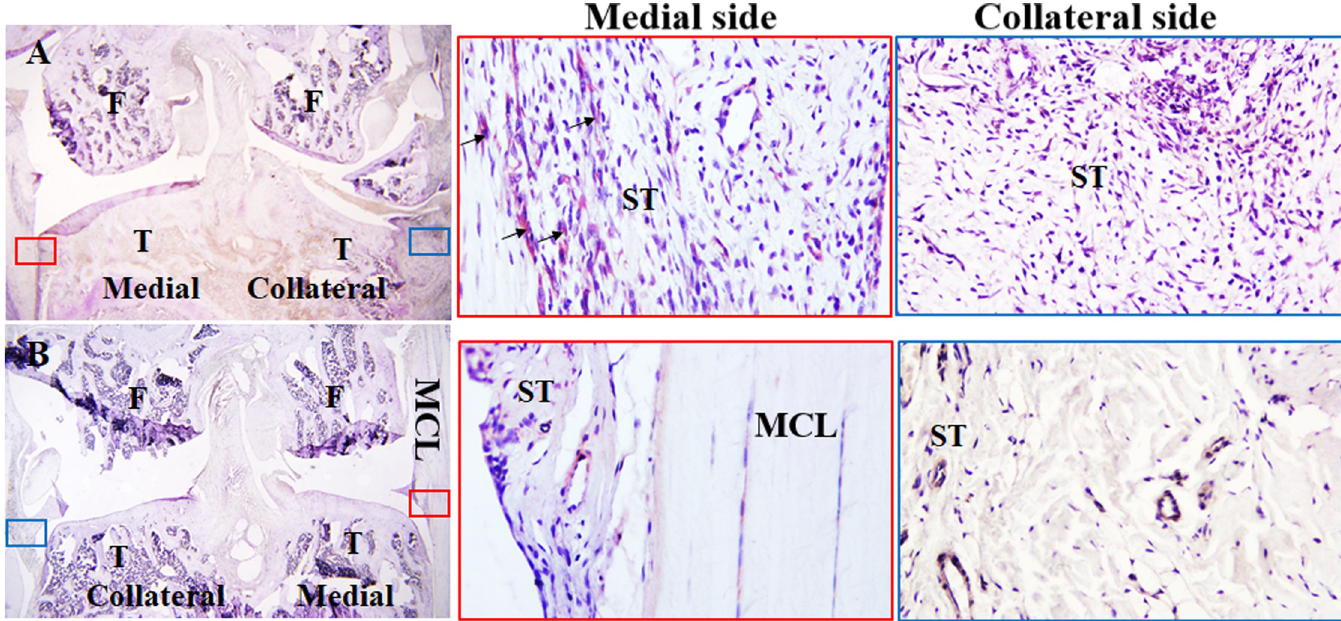
Fig 5. IL-6 synthesis is induced in response to MMD at three days post-surgery. Immunohistochemistry staining was performed using antibodies against rat IL-6 for both rat MMD- ( A ) and the left sham-operated knees ( B ) collected at day 3 post-surgery. Representative images of histology sections collected from rat MMD- ( A ) and sham-operated knees (B), brown color represents IL-6 positive areas. Arrows show some of IL-6 positive stained areas. The squares in the left panels represent the areas magnified 20x on the right panels. T. tibia plateau, F. femur condyles, ST, synovial tissue. MCL, medial collateral ligament. A and B were taken using 1.25x microscope